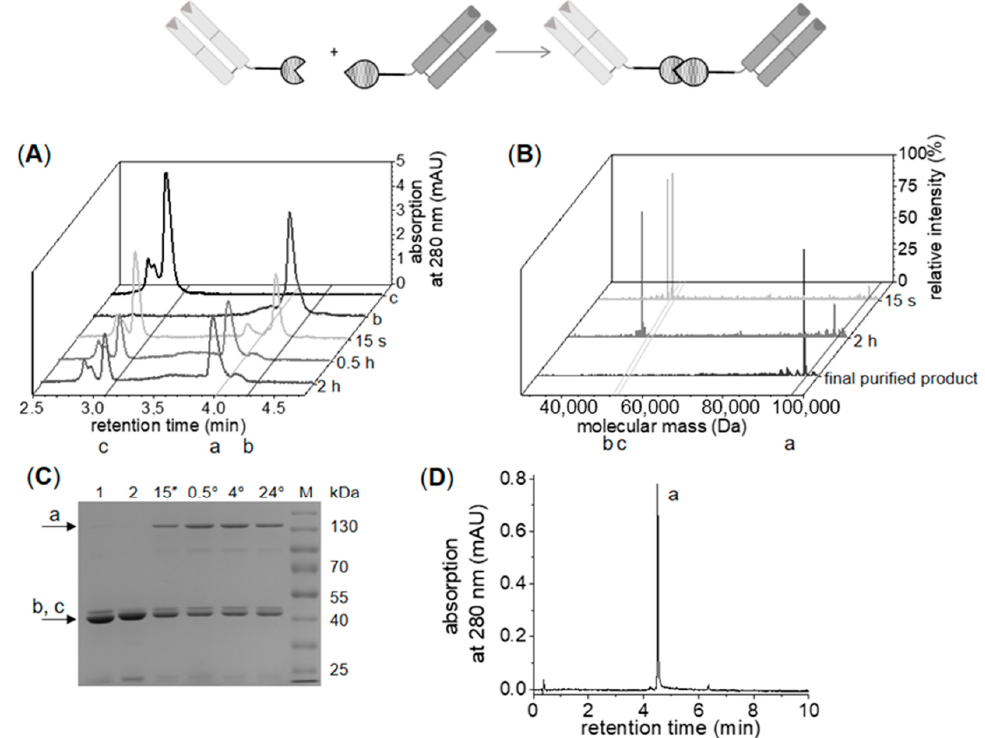
Figure 4. Course and analysis of the click reaction of eTl synthesized anti-ErbB3-Fab-MeTz with anti-ErbB2-Fab-TCO forming anti-ErbB3-Fab-IEDDA-anti-ErbB2-bsFab. ( A ) Time-resolved UPLC analysis of the click reaction showing a complete conversion within 0.5 h of the reaction time, a: anti-ErbB3-Fab-IEDDA-anti-ErbB2-bsFab, b: anti-ErbB3-Fab-MeTz, c: anti-ErbB2-Fab-TCO; ( B ) MS analysis of the click reaction after reaction start, 2 h reaction time and, of the final conjugation product (a: anti-ErbB3-Fab-IEDDA-anti-ErbB2-bsFab M calcd : 96,536 Da, M found : 96,537 Da, b: anti-ErbB3- Fab-MeTz M calcd : 47,704 Da, M found : 47,705 Da, c: anti-ErbB2-Fab-TCO M calcd : 48,860 Da, M found : 48,861 Da); ( C ) Time-resolved SDS-PAGE analysis of the click reaction (1: anti-ErbB3-Fab-MeTz, 2: anti- ErbB2-Fab-TCO, M: molecular marker); ( D ) UPLC profile of anti-ErbB3-Fab-IEDDA-anti-ErbB2- bsFab conjugate after purification via SEC. Light grey Fab: anti-ErbB3-Fab-MeTz, dark grey Fab: anti-ErbB2-Fab-TCO. Reaction conditions: 30 µM anti-ErbB3-Fab-MeTz, 60 µM anti-ErbB2-Fab-TCO